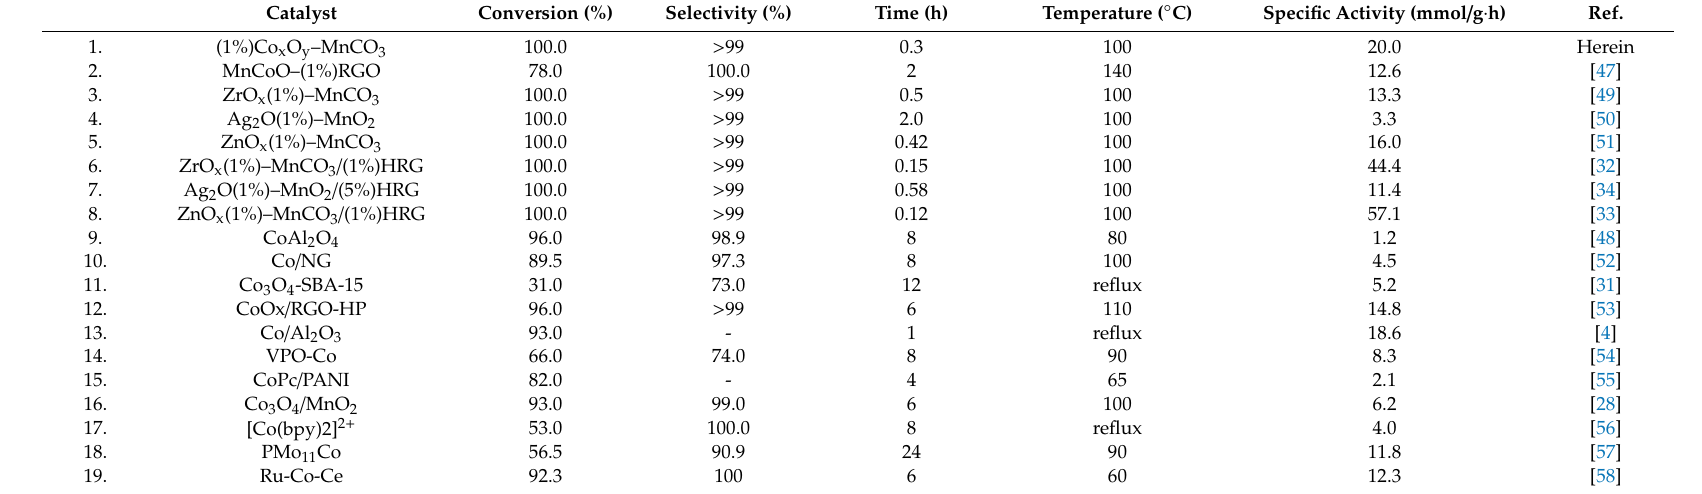
Table 5. Comparison of the effectiveness our catalyst and previously-reported cobalt-containing